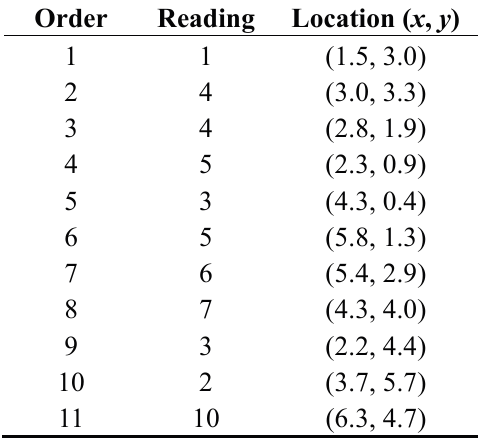
Table 1. The Discover-Information contained in the